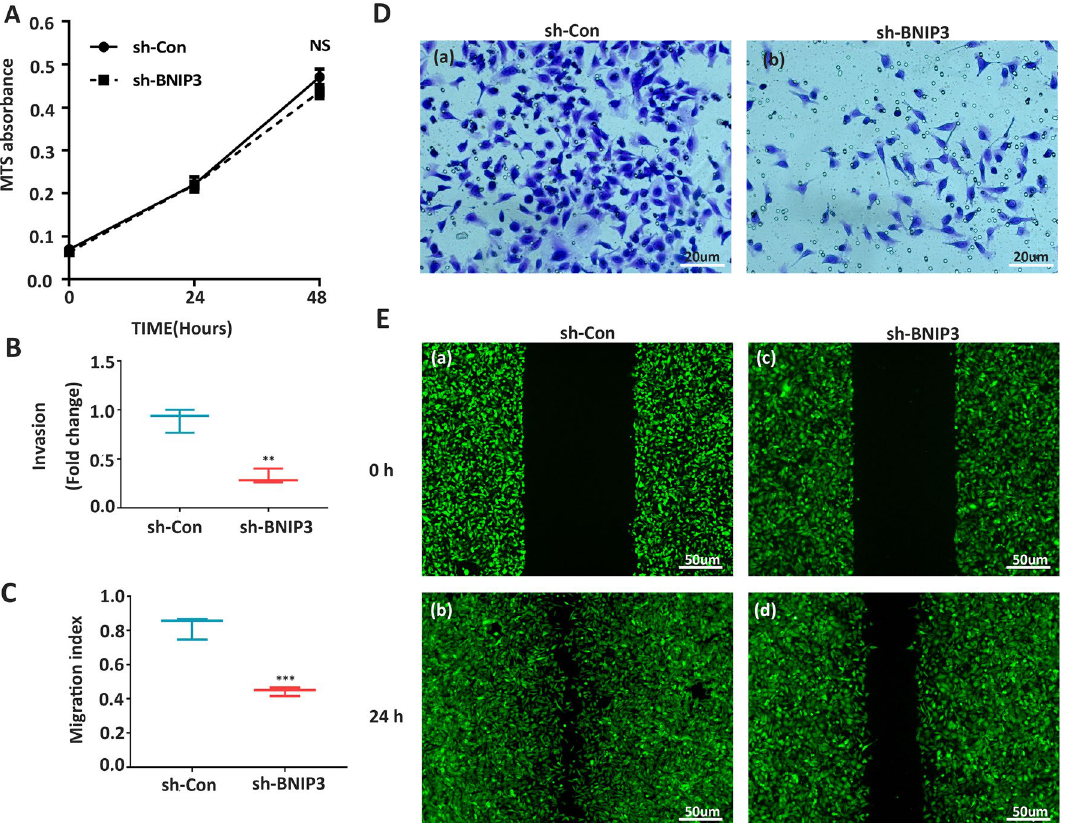
Figure 4. Downregulation of BNIP3 attenuated invasion and migration of trophoblast cells. ( A ) MTS assay on HTR-8/SVneo cells after sh-RNA transfection of 0 h, 24 h, and 48 h (n = 3 per group). ( B , D ) Matrigel